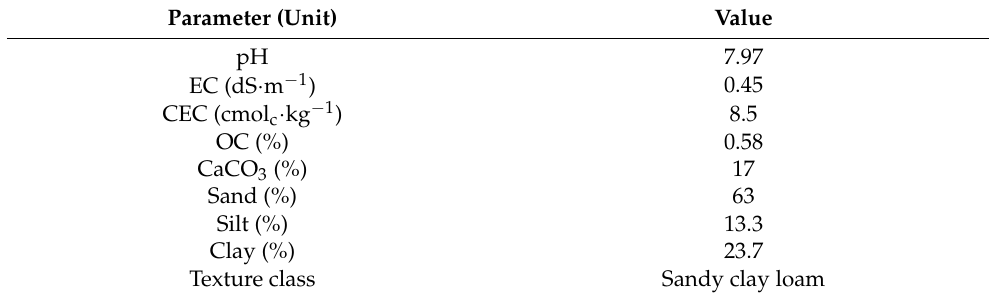
Table 1. The main characteristics of the test soil. (OC: organic carbon, CEC: cation exchange